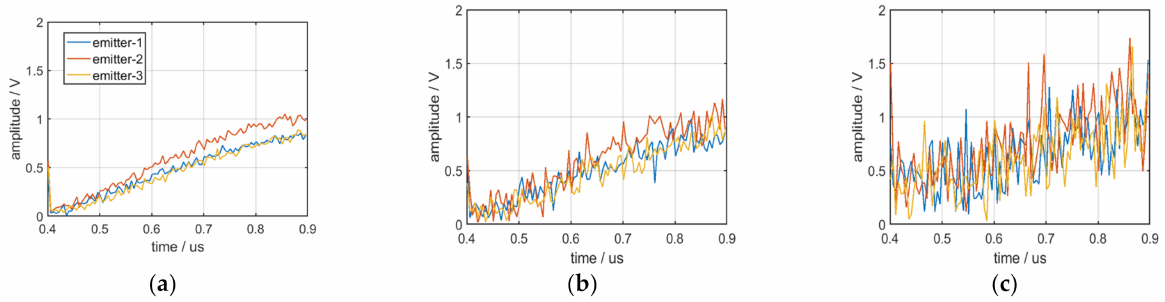
Figure 18. ( a ) Envelope of the pulse front edge at 30 dB SNR; ( b ) envelope of the pulse front edge at 20 dB SNR; ( c ) envelope of the pulse front edge at 10 dB SNR.